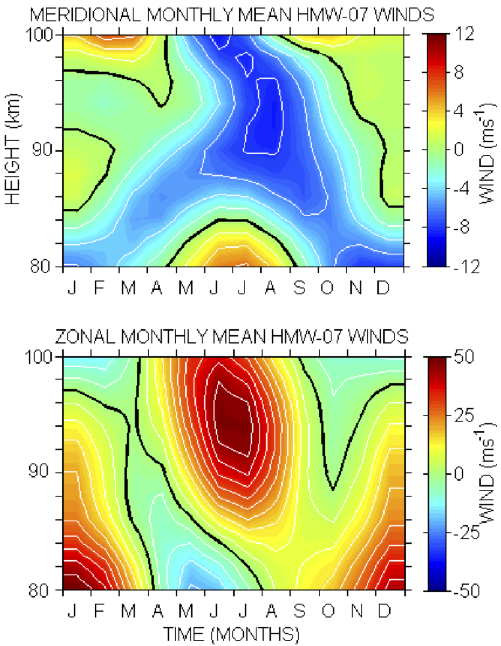
Fig. 3. Monthly-mean meridional and zonal winds over BLO (41.9 ◦ N and 111.4 ◦ W), from the HWM-07 model. The zero wind line is indicated in black and the white lines indicate 5 ms − 1 steps.